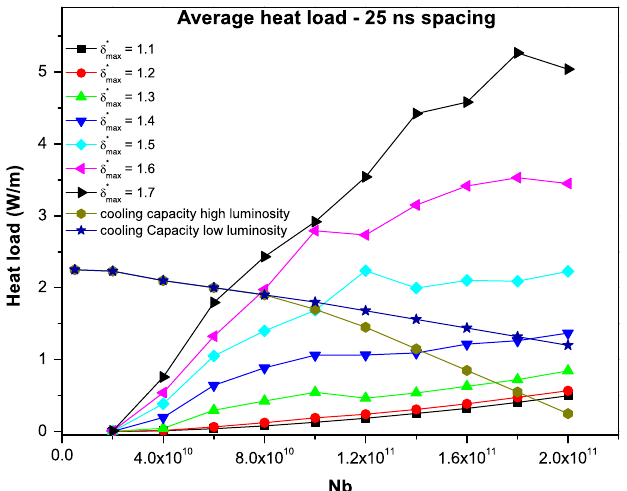
FIG. 9. Average heat load for the simulation set A.